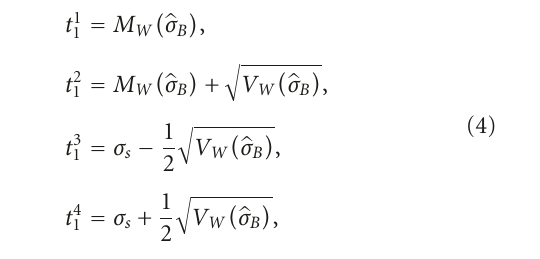
Figure 5: the relationship between the first two statistical orders is taken into account by using the thresholds in standard deviation and mean estimated by the automatic segmentation, the third and fourth statistical moments are used after focusing and rebuilding operations.